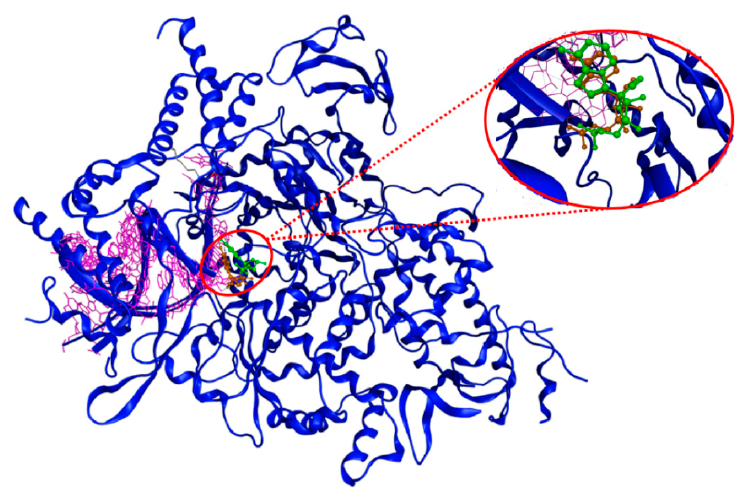
Figure 7. Overlapping of X-ray derived structure of RdRp (7BV2) and PatchDock results of the complex with GS-441524. Ribbon structure of Protein and RNA in blue, atoms of RNA in magenta, GS-441524 covalently linked by X-ray analysis in green, GS-441524 covalently linked by docking calculation in orange.